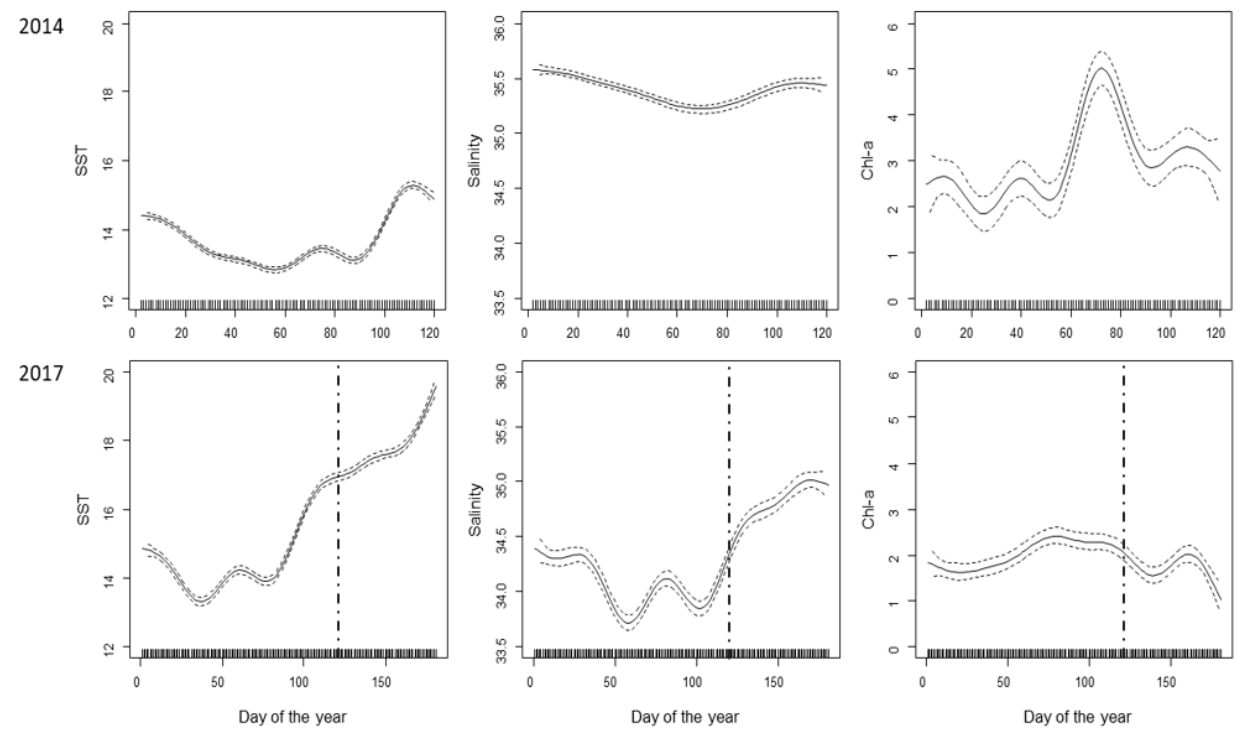
Figure 2. Estimated smoothing curves of day of the year for Sea Surface Temperature (SST, ◦ C), Sea Surface Salinity (SSS) and Chlorophyll-a concentration (Chl-a, mg/m 3 ) from 2014 and 2017, expressed as a mean between locations along the Portuguese coastline. Results of the General Additive Model showing the effect of the variable “day of the year” (Julian year). Dashed lines show a 95% Confidence Interval and tick marks along the x -axis represent when observations occurred. Vertical dashed line (2017) is a reference to the last day from 2014 (day 120).